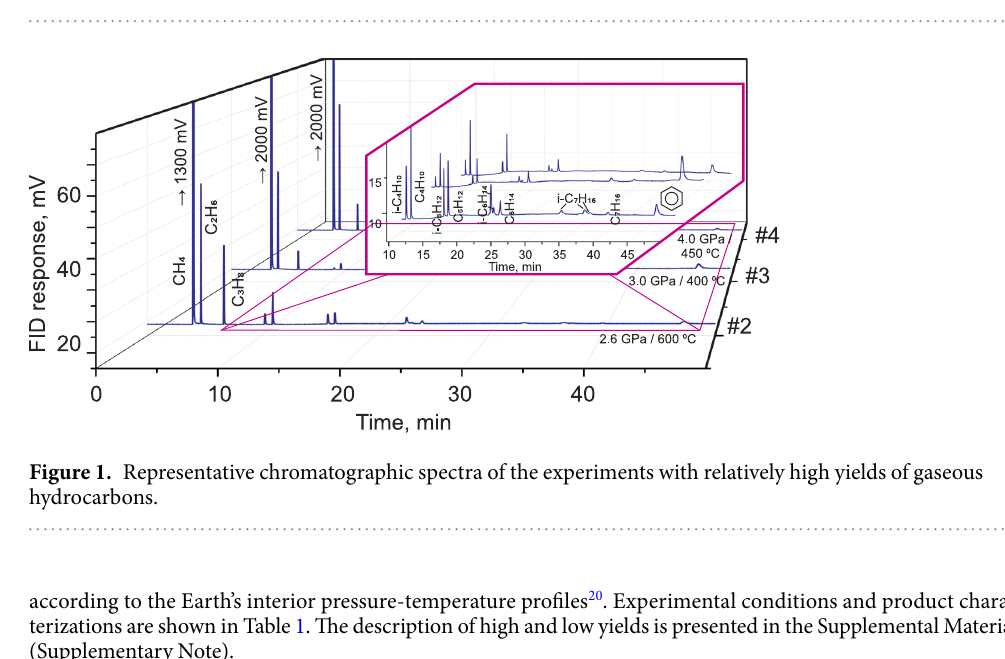
Table 1. The conditions of the conducted experiments. All performed experiments were heated in 60 s, exposed for 2 h, and cooled instantly (quenched).